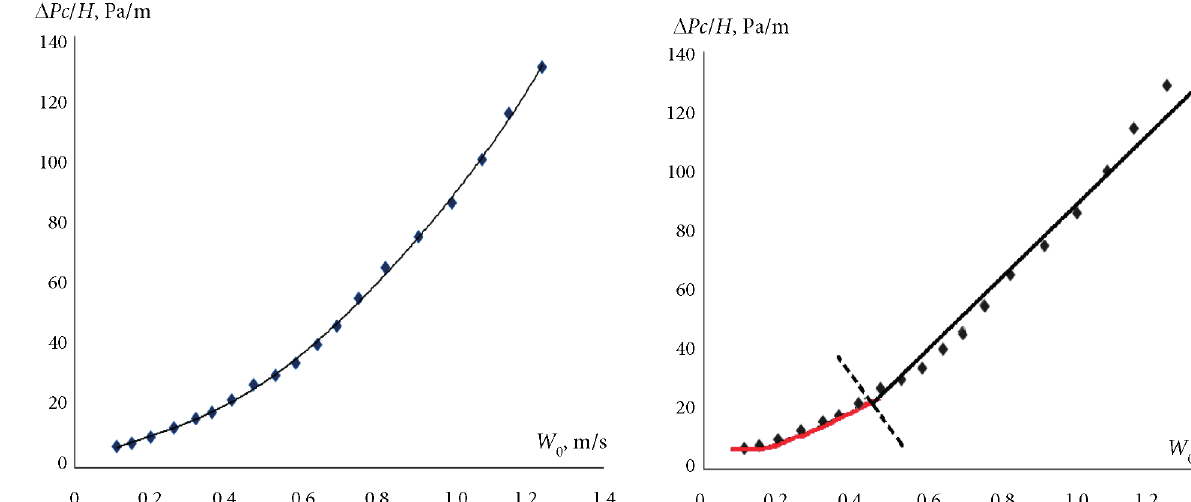
Fig. 6. Dependence of the pressure drop Δ Pс/H on the air for the dry packing under test (pine cones) velocity W 0